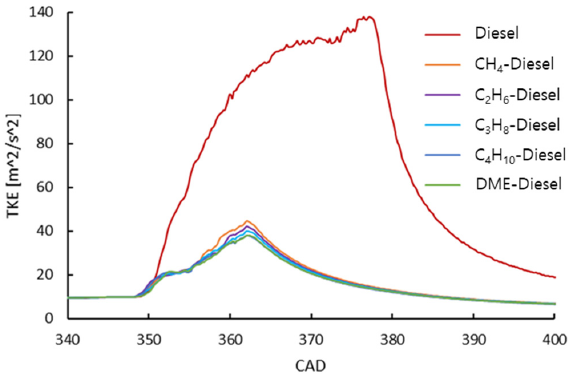
Figure 8. Mean TKEs of the fluid flow in the engine cylinder in all operating modes.